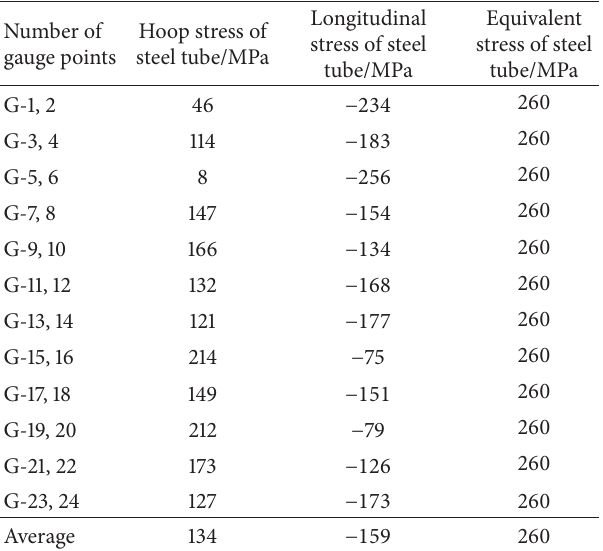
Table 5: Stresses of steel tube in specimen